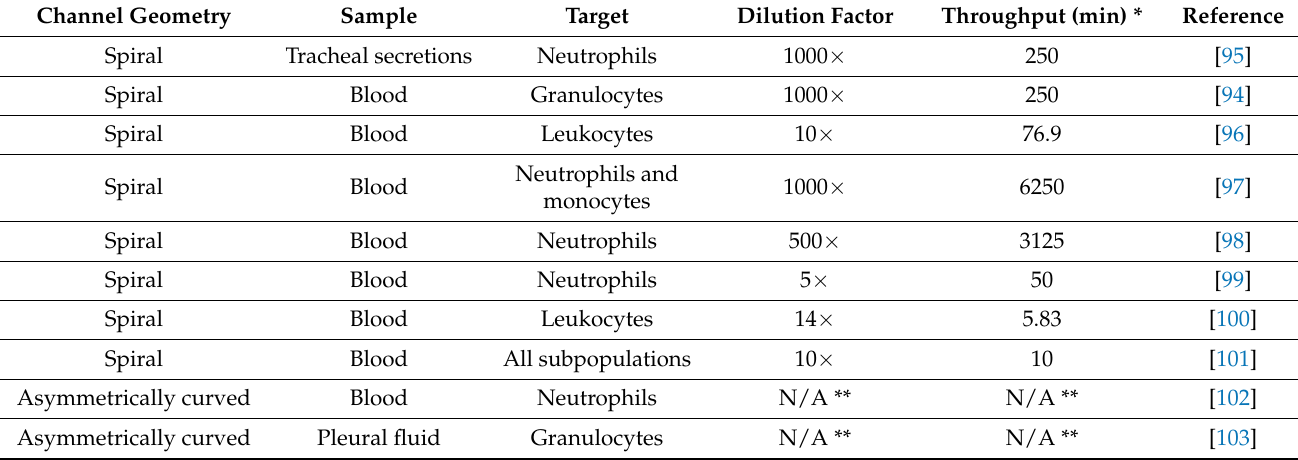
Table 1. Summary of literature on IM based WBC separation and assaying, discussed in this review paper. Key features highlighted are: channel geometry, sample type, WBC target, dilution factor, and throughput. References listed for further